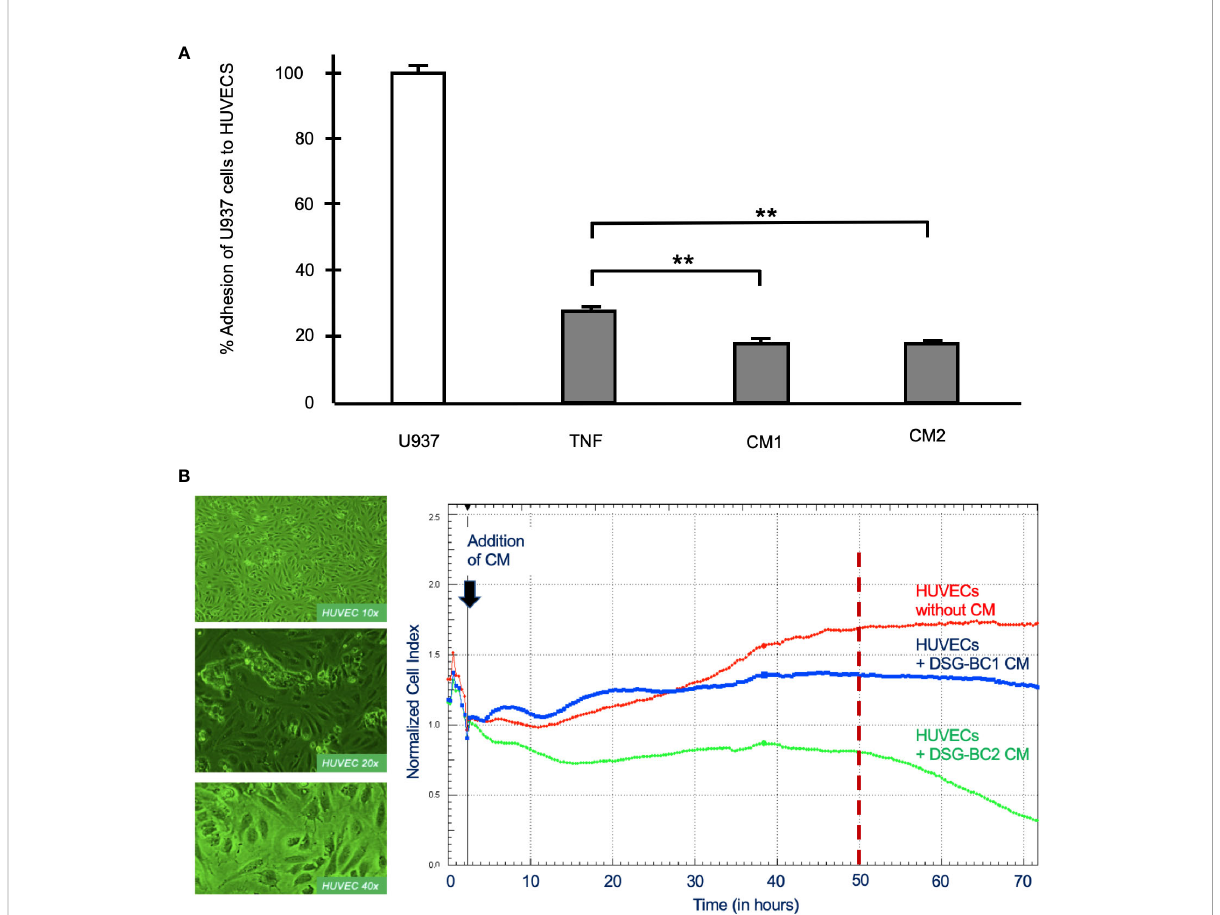
FIGURE 9 Breast cancer cells derived from patients with obesity or normal weight secreted similar amounts of soluble factor capable promoting endothelial cell activation. (A) % Adhesion of 3H-thymidine-labeled U937 cells to HUVECs treated for 3 hours with CM from DSG-BC1 or DSG-BC2 as described in materials and methods. 100% corresponds to the amount of radioactivity in 250,000 U937 cells (white bar). Normalized amount of radioactivity bound in HUVECS treated with TNF (10 ng/ml) or with 1:10 dilution of the CM from DSG-BC1 or DSG-BC2 (gray bars), n = 3. Brackets indicate comparisons with p value < 0.05 (*) or a p value < 0.01 (**). (B) Left panel: micrographs of endothelial cell monolayers at the indicated magni fi cations, taken before adding CM. Right panel: representative change in impedance in monolayers of HUVECs treated with a 1:10 dilution of CM of the indicated cell lines. CM were prepared as described in materials and methods and added 48 hours after plating (black arrow). Impedance was measured every 30 minutes as described in materials and methods. CM: conditioned media from the indicated cell